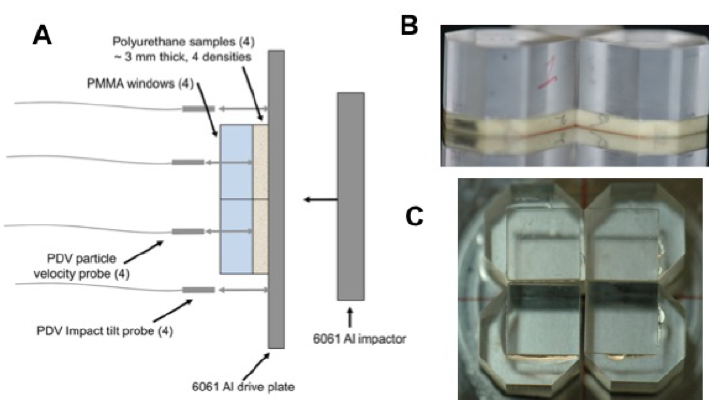
Figure 8. Multi-slug target configurations used at LANL large-bore two-stage gun to obtain up to 4 Hugoniot states in a single experiment. ( A ) Four foam samples with different initial densities were glued to the rear surface of a driveplate made of 6061 Al or other EOS standard material. ( B ) The samples were then windowed individually using PMMA. ( C ) A 5–6 µ m Al foil was glued onto the PMMA window to provide a reflective surface for measuring shock wave arrival following transit through the foam.